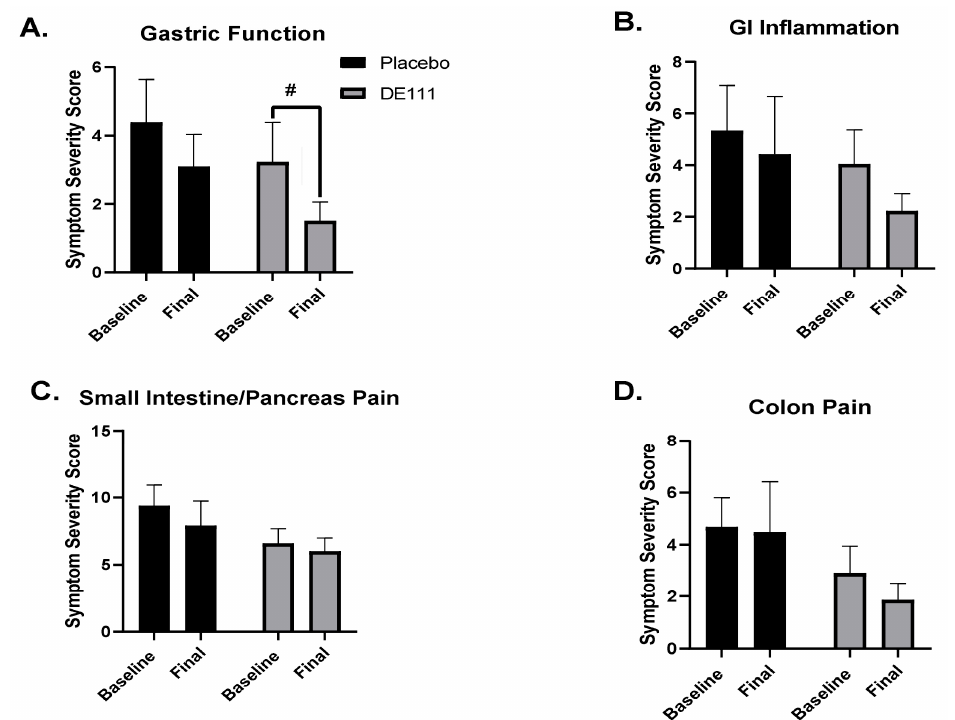
Figure 2. Symptom severity scores were based on answers to a GI symptom questionnaire by Metagenics [16] that is designed to provide a functional measure to assess symptoms associated with gastric function ( A ), gastrointestinal inflammation ( B ), small intestine/pancreas pain ( C ), and colon pain ( D ). Error bars represent ±SEM, # indicates a statistical trend ( p = 0.051–0.08).